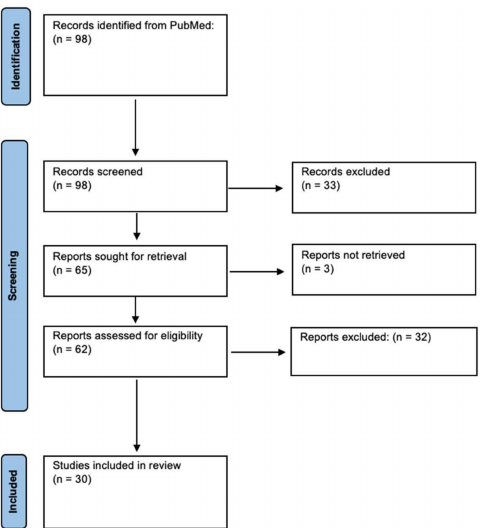
Figure 1. Identification of Studies via PRISMA